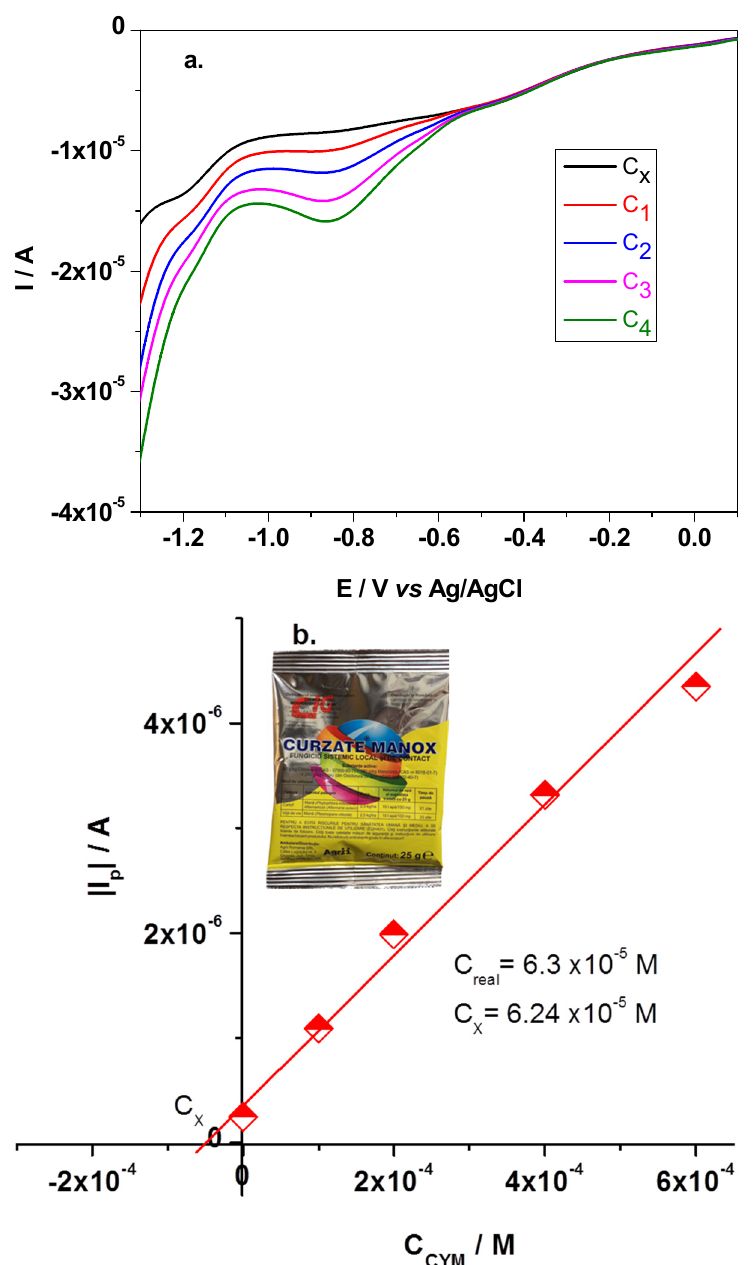
Figure 9. LSVs recorded with NB-Gr/GC electrode in CURZATE MANOX solutions containing various CYM concentra-